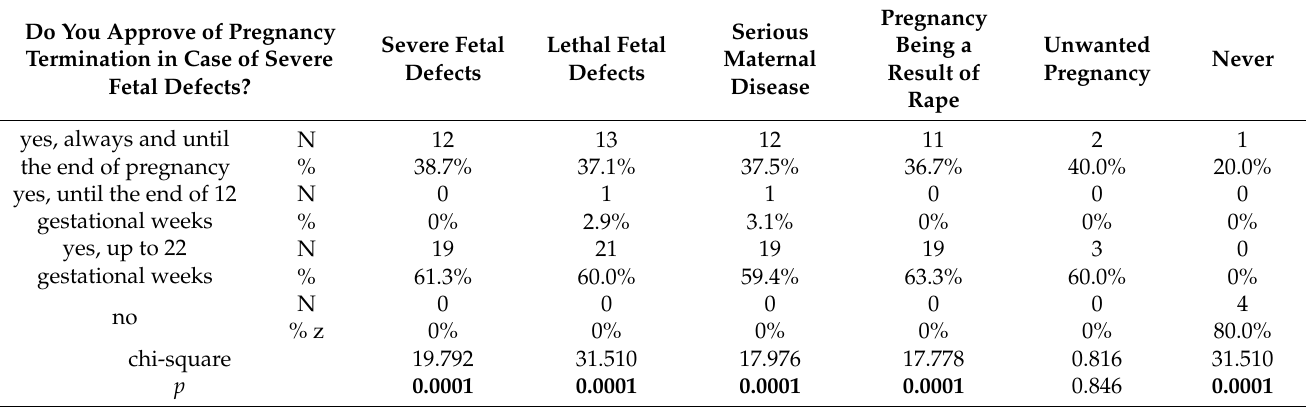
Table 3. Approval of pregnancy terminations in case of severe fetal defects vs. approval of other indications for terminations (N = 40).